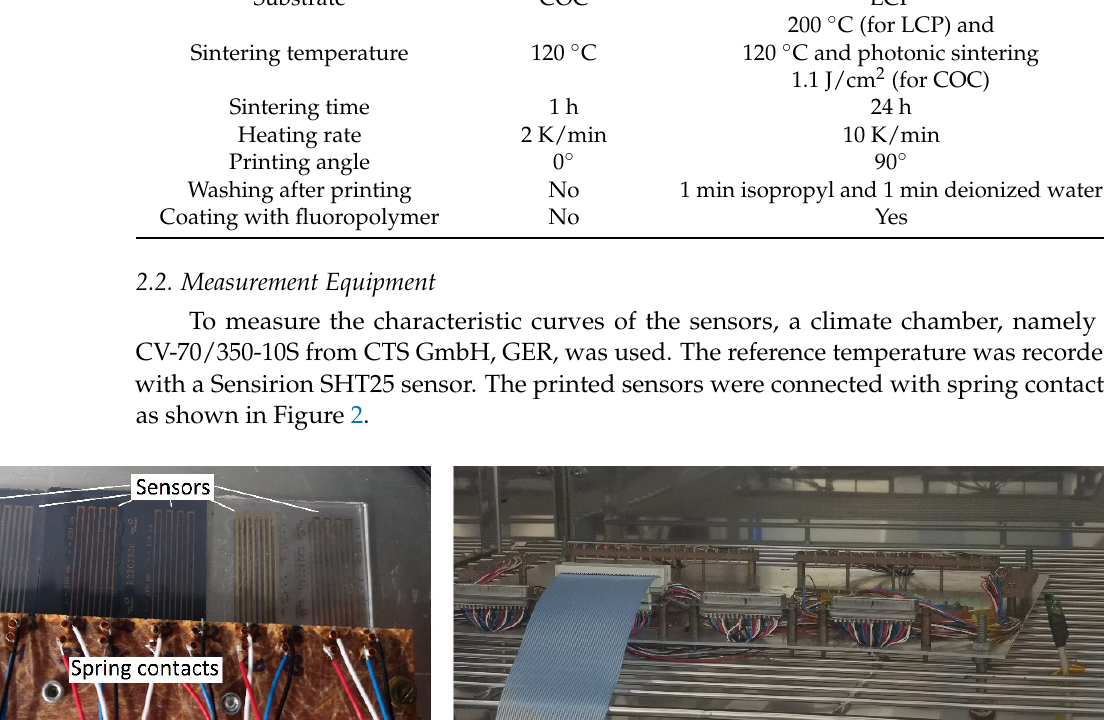
Figure 3. Block diagram of the measurement setup. Four-terminal sensing with separate wiring for current and voltage eliminates the influences of the measuring lines. Scanning electron microscope (SEM) images were taken with a FEI Helios Nanolab DualBeam with an in-lens detector from Thermo Fisher, Waltham, MA, USA. 2.3. Measurement and Evaluation of the Characteristic Curve The measurements of the characteristic curves were conducted according to IEC 61298-2 [25]. A preconditioning was carried out before the measurement. The sensors were cycled three times through the measurement range. To measure the characteristic curve, three measurement cycles were conducted with six test points at 0%, 20%, 40%, 60%, 80%, and 100% of the full-scale output (FSO) of the sensor. The FSO describes the difference between the output signals measured at the maximum and minimum applied temperature [26]. As the measurement range of the sensor is 10 °C to 85 °C, the full scale gives a range of 75 °C. Between the measurement points, the temperature was changed with a slope of 1 °C/min. The temperature was kept constant for 15 min before the meas- urement was conducted to ensure a uniform temperature distribution in the chamber and within the sensors. The humidity was kept constant at 60% RH during the measurement. This level of humidity allows us to evaluate the cross-influence of this disturbance varia- ble. Very low values of humidity would make an evaluation of this influence difficult.